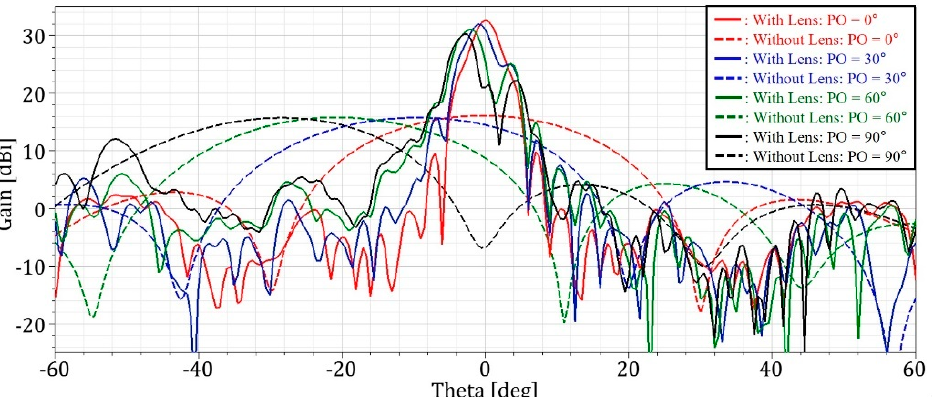
Figure 15. Simulated radiation patterns for 4 × 4 antenna array combined with the lens in case of each input phase offset.